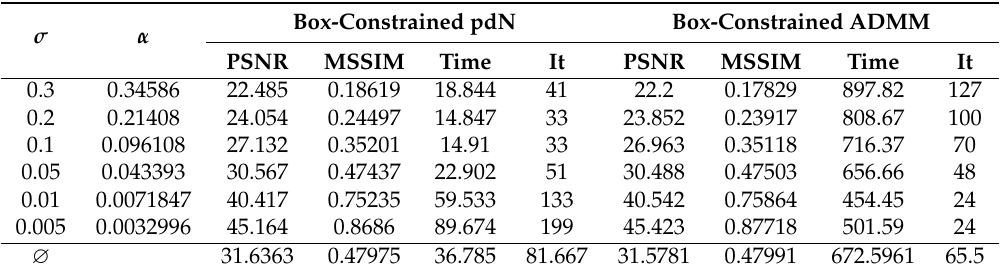
Table 5. Reconstruction of the cameraman-image corrupted by Gaussian white noise with standard deviation σ .